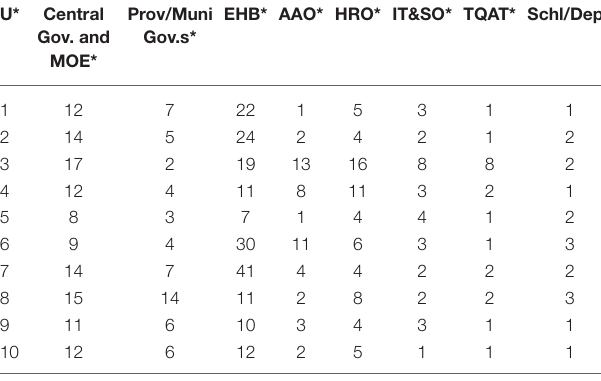
TABLE 3 | Official policies from different sources. U* Central Gov.